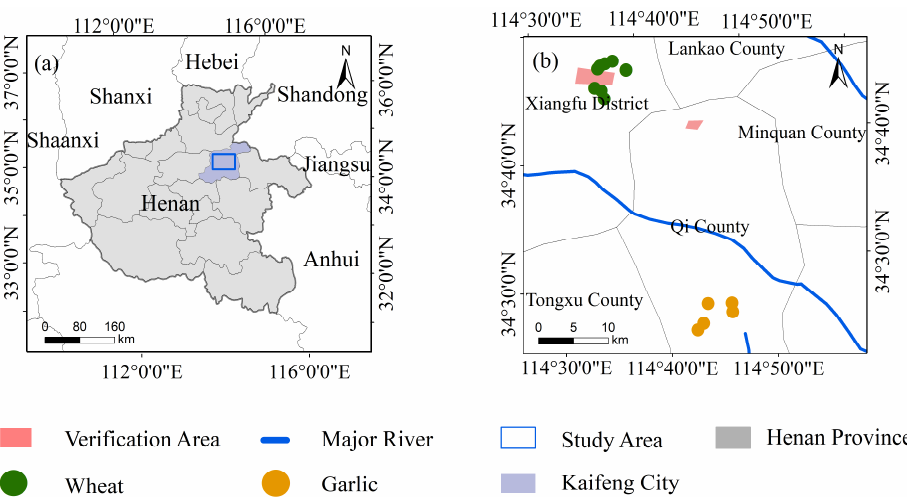
Figure 1. ( a ) The location of the field survey sites in Kaifeng, Henan Province, China. ( b ) The location of the study area within Henan